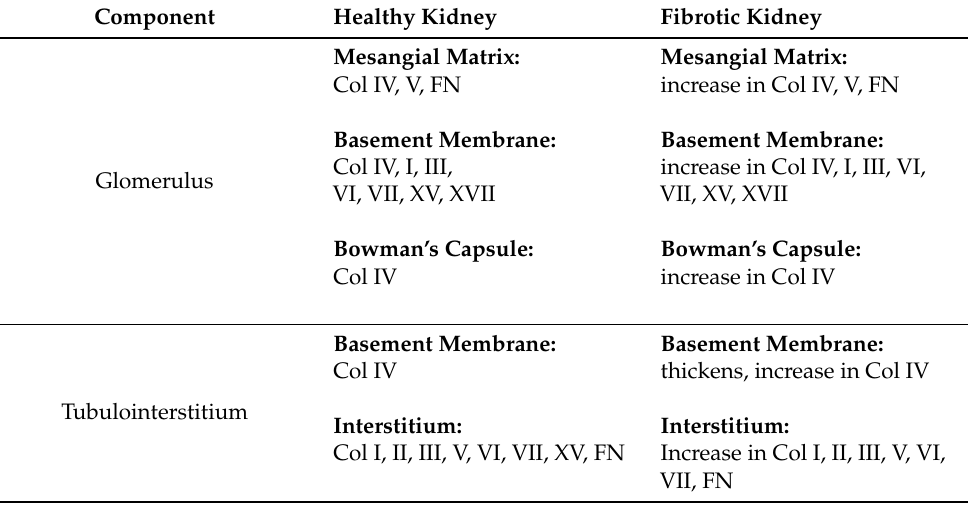
Table 1. Changes in ECM composition during renal fibrosis. This table summarizes changes in ECM composition in the glomerulus and tubulointerstitium during the progression of renal fibrosis.